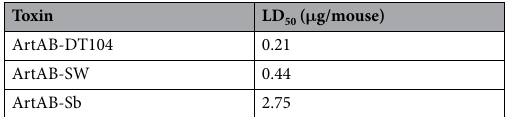
Table 1. Lethal activity of ArtAB toxins injected i.p. into BALB/c